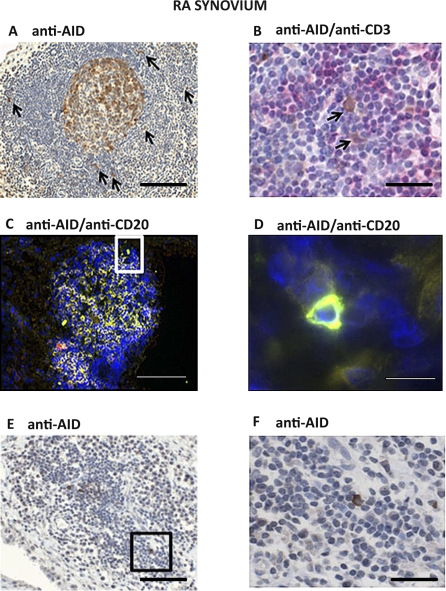
AID Expression within the Rheumatoid Synovial Membrane Identifies Interfollicular Large B Cells(A) Paraffin-embedded sections from RA patients were stained for AID (20× magnification). AID+ cells with a large cytoplasm and sometimes dendritic-like morphology (arrows) were frequently and exclusively seen in RA synovial tissue characterized by the presence of large aggregates predominantly in close proximity to CD21+ FDC networks.(B) Paraffin sections were double stained for AID (brown) and CD3 (red) (60× magnification), demonstrating the close relationship between AID positive cells (arrows) and T cells in the peripheral T cell areas of the lymphoid aggregates.(C) Merged double staining for AID (red) and CD20 (green) on frozen RA sections confirmed that AID+ cells were of B cell origin (double-stained cells are identified in yellow).(D) Higher magnification of an example of an AID+/CD20+ cell (60× magnification of [C]).(E and F) Scattered AID+ cells (E) with the appearance of IF B cells (F) were occasionally found away from the central focus of the aggregate. Scale bars: 200 μm (A, C, E), 50 μm (B, F), 15 μm (D).